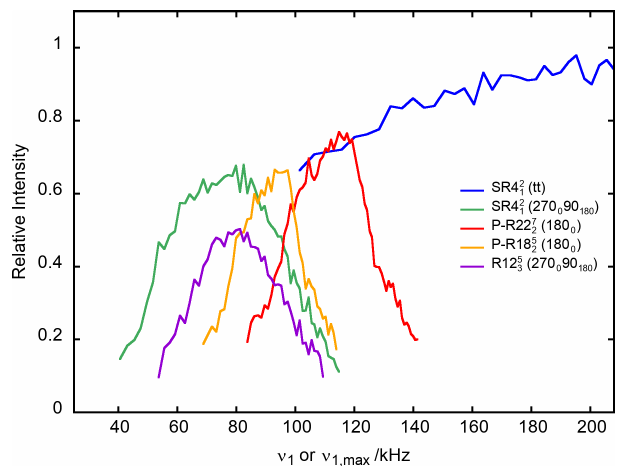
Figure 4. The 27 AlO 6 on-resonance signal of γ -alumina at ν R = 20kHz as a function of ν 1 or ν 1 , max for PRESTO-R22 7 (180 0 ) and 2 PRESTO-R18 5 (180 0 ) as well as RINEPT-CWc-SR4 2 (tt), RINEPT- 2 1 SR4 2 (270 0 90 180 ) and RINEPT-R12 5 (270 0 90 180 ). For each curve, 1 3 τ was fixed to its optimum value given in Table 1.